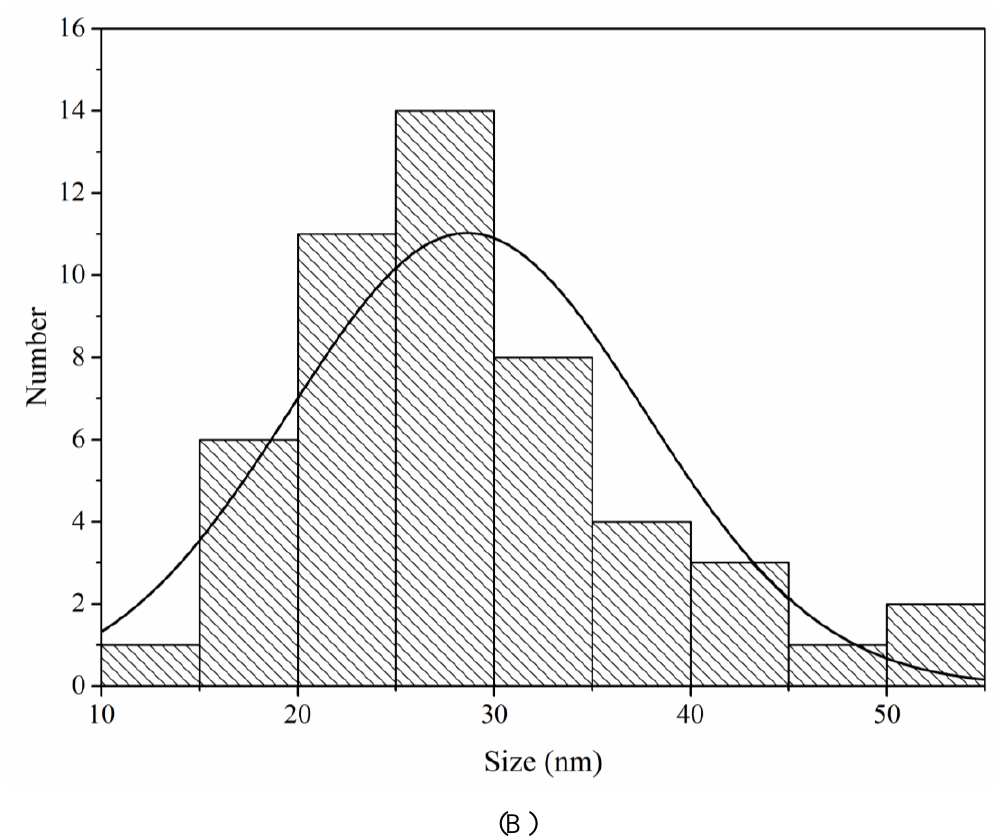
Figure 3. ( A ) The TEM image, and ( B ) the particle size distribution of biosynthesized AgCl-NPs using aerial part extracts of the P. vulgaris plant obtained based on TEM images (number of particles = 50). Each bar represents the number of nanoparticles having a size within the particular size range.